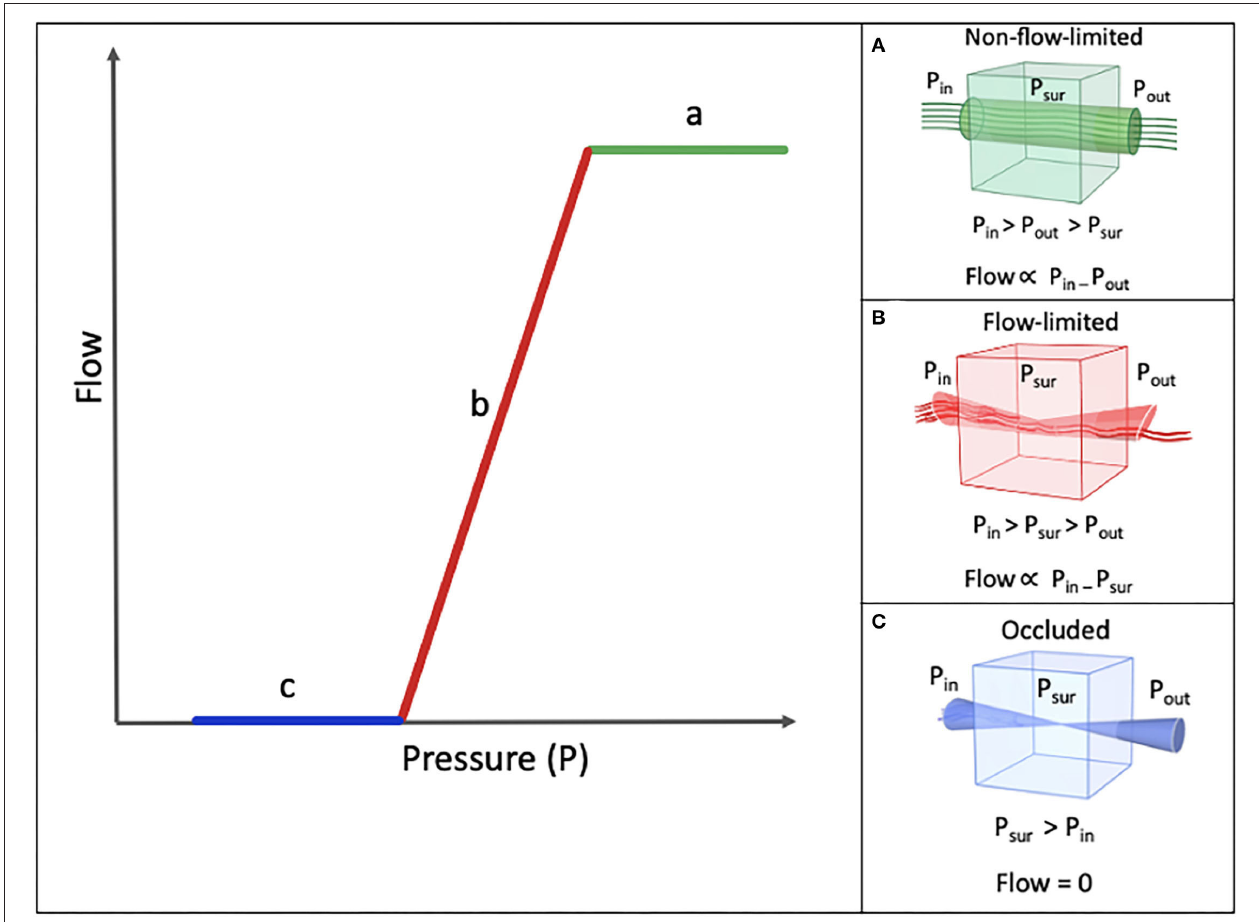
FIGURE 1 | Schematic model of Pressure-Flow relationship. P in (inflow pressure), P out (Outflow pressure), and P sur (surrounding pressure). (A) Nonflow-limited segment. (B) Flow-limited segment. (C) Occluded